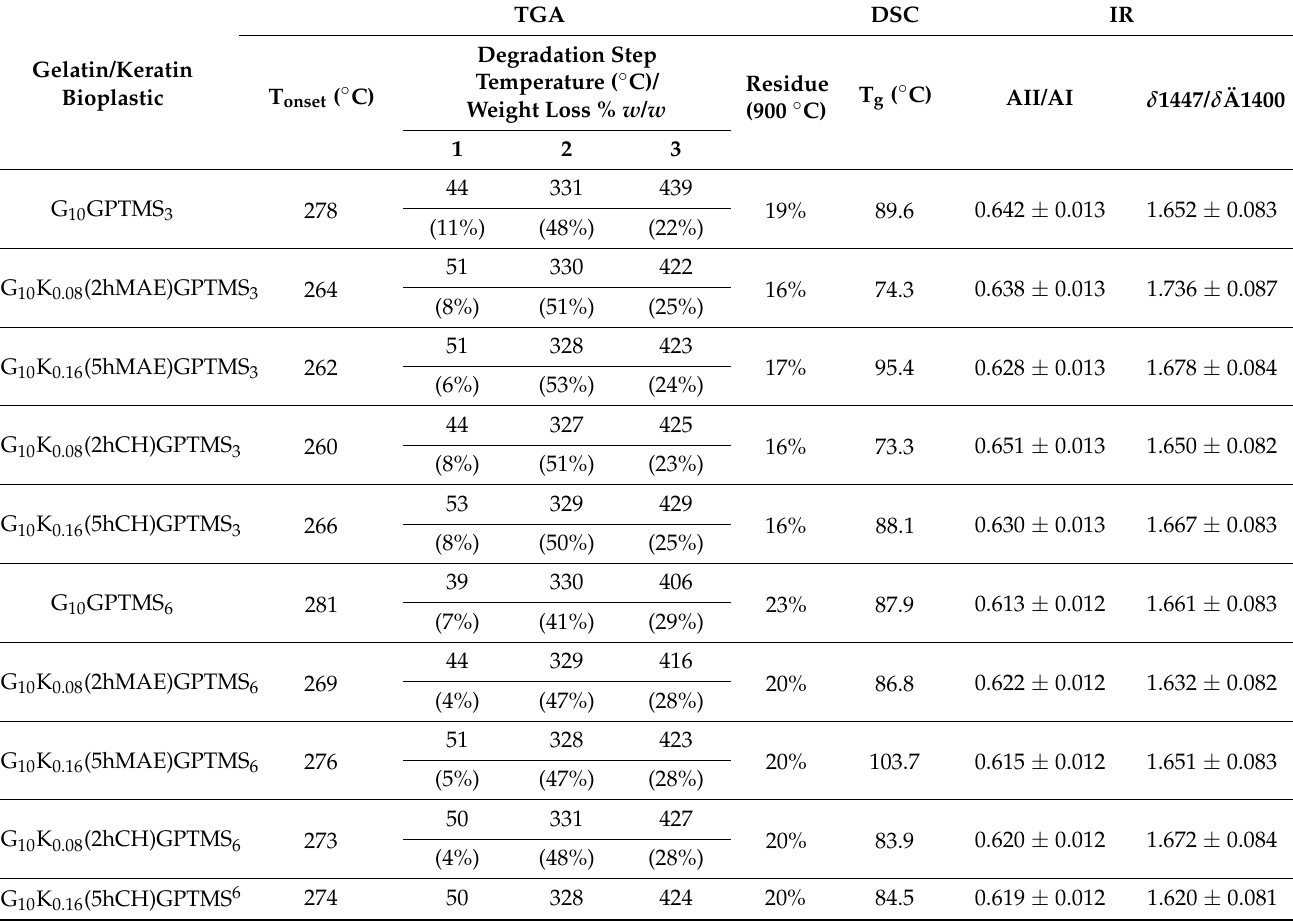
Table 4. Parameters obtained from TGA (T onset , degradation step, residue), DSC (glass transition temperature = T g ) and IR analysis (Amide II/Amide I ratio = AII/AI and bending 1447/1400 ratio = δ 1447/ δ